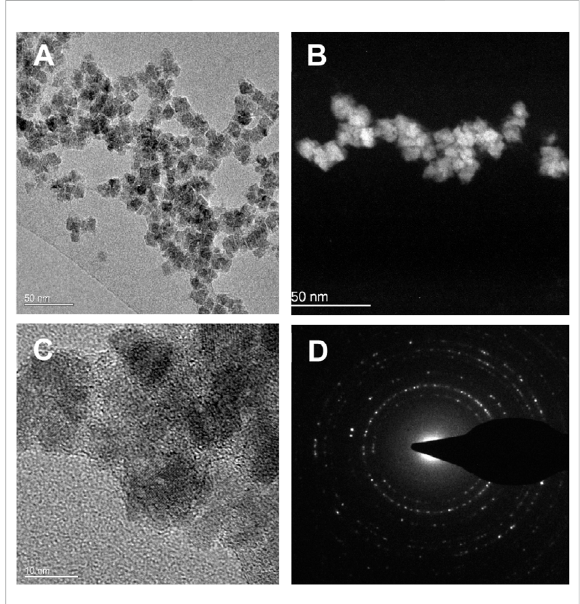
FIGURE 2 Transmission electron microscopy images of as-synthesized Fe 3 O 4 -PEG-PLGA nanomaterials. (A) TEM phase contrast image; (B) HAADF-STEM image; (C) HREM phase contrast image; (D) SAED polycrystalline pattern rings. Scale bars: (A,B) 50 nm; (C) 10